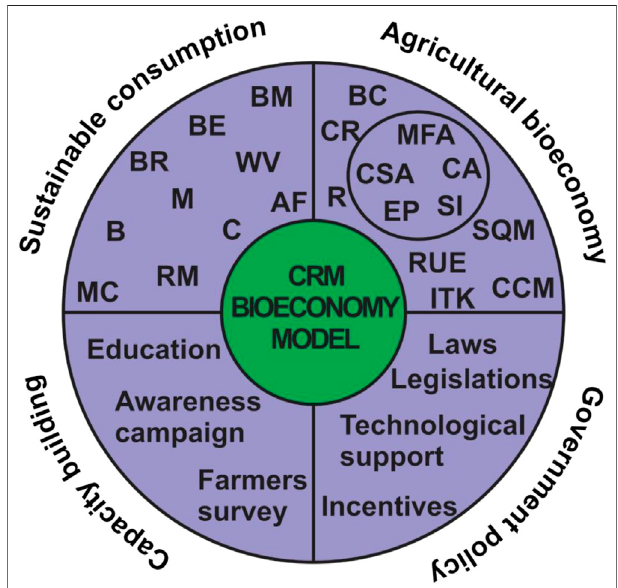
FIGURE 9 | Crop Residue Management – A bioeconomy model. Agricultural bioeconomy quadrant: SI, Sustainable Intensi fi cation; CSA, Climate-SmartAgriculture;MFA,MultifunctionalAgriculture;CA,Conservation Agriculture; EP, Energy Plantations; BC, Biodiversity Conservation; CR, Climate Resilience; CCM, Climate Change Mitigation; SQM, Soil Quality Management; R, Resilience of biomass producers; RUE, Resource Use Ef fi ciency; ITK-Indigenous Traditional Knowledge. Sustainable consumption quadrant: BR, Biore fi nery; BE, Biomass Energy; BM, Building Material; B, Biofuel; MC, Mushroom Cultivation; M, Mulch; WV, Waste Valorization; AF, Animal Feed; C, Compost; RM, Roo fi ng